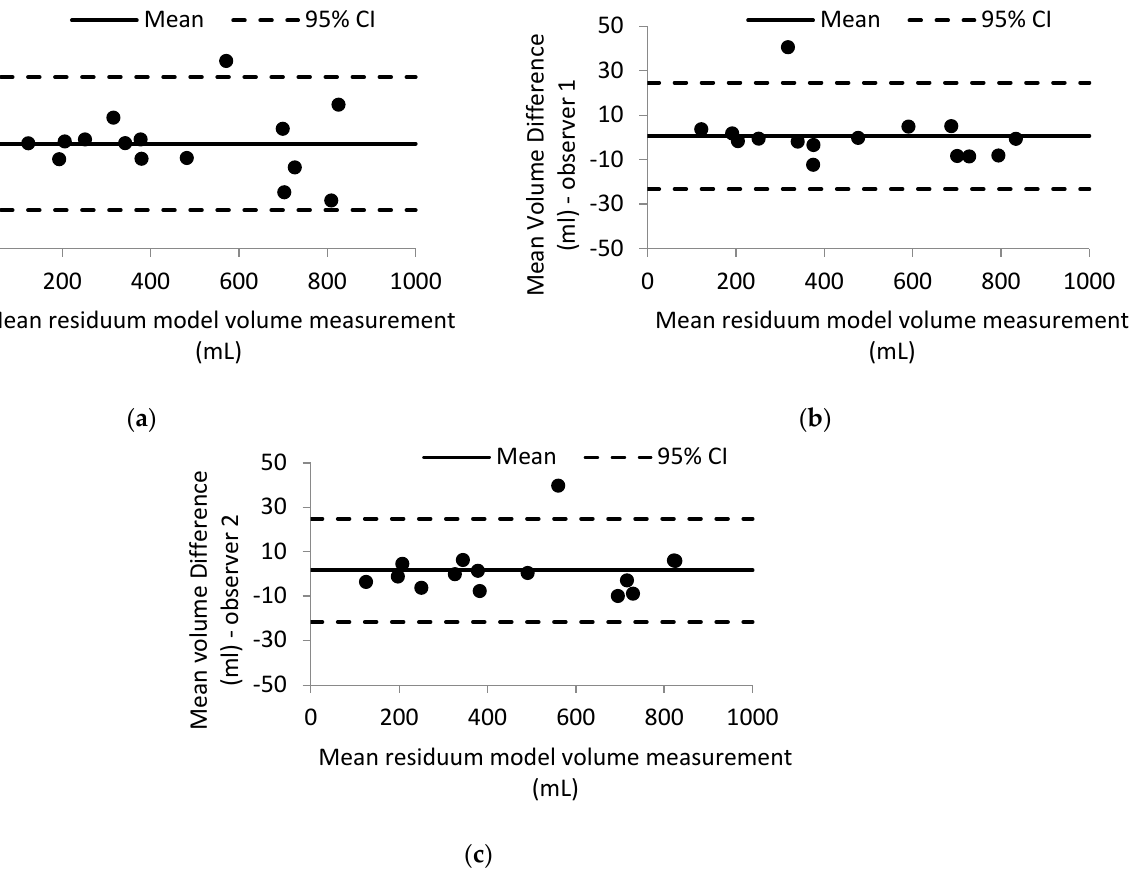
Figure 5. ( a ) Bland-Altman plot of mean volume difference of residuum models ( a ) between observers 1 and 2, ( b ) between repeated measurements by observer 1; and ( c ) between repeated measurements by observer 2.